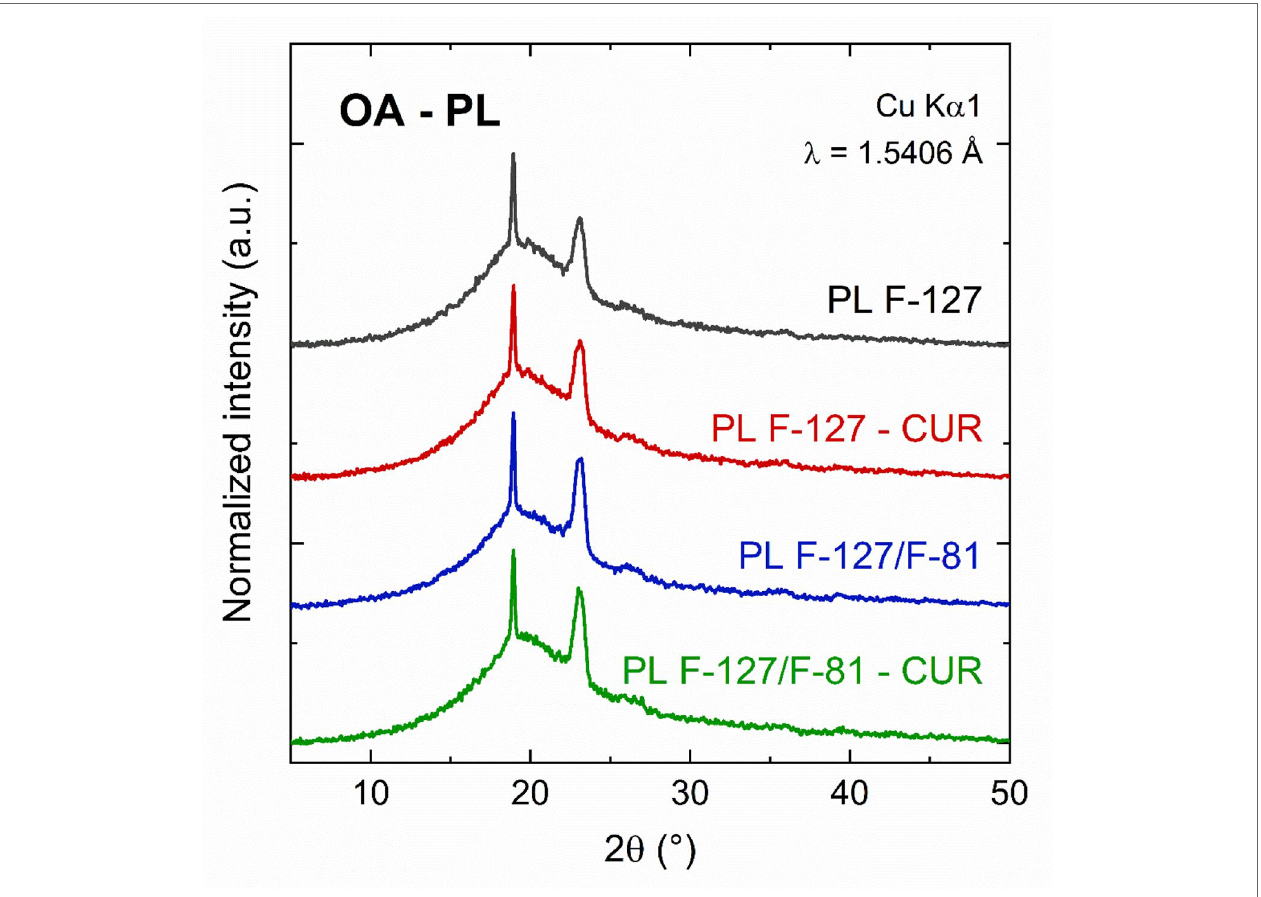
FIGURE 2 | X-ray diffraction patterns for the ORG formulations OA-PL F-127, OA-PL F-127-CUR, OA-PL F-127/L-81, and OA-PL F-127/L-81-CUR (OA, oleic acid; PL F-127, Pluronic ® F-127; PL L-81, Pluronic ® L-81; and CUR,